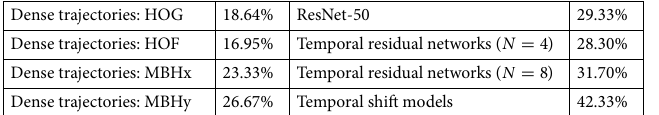
Table 3. Performance for video classification